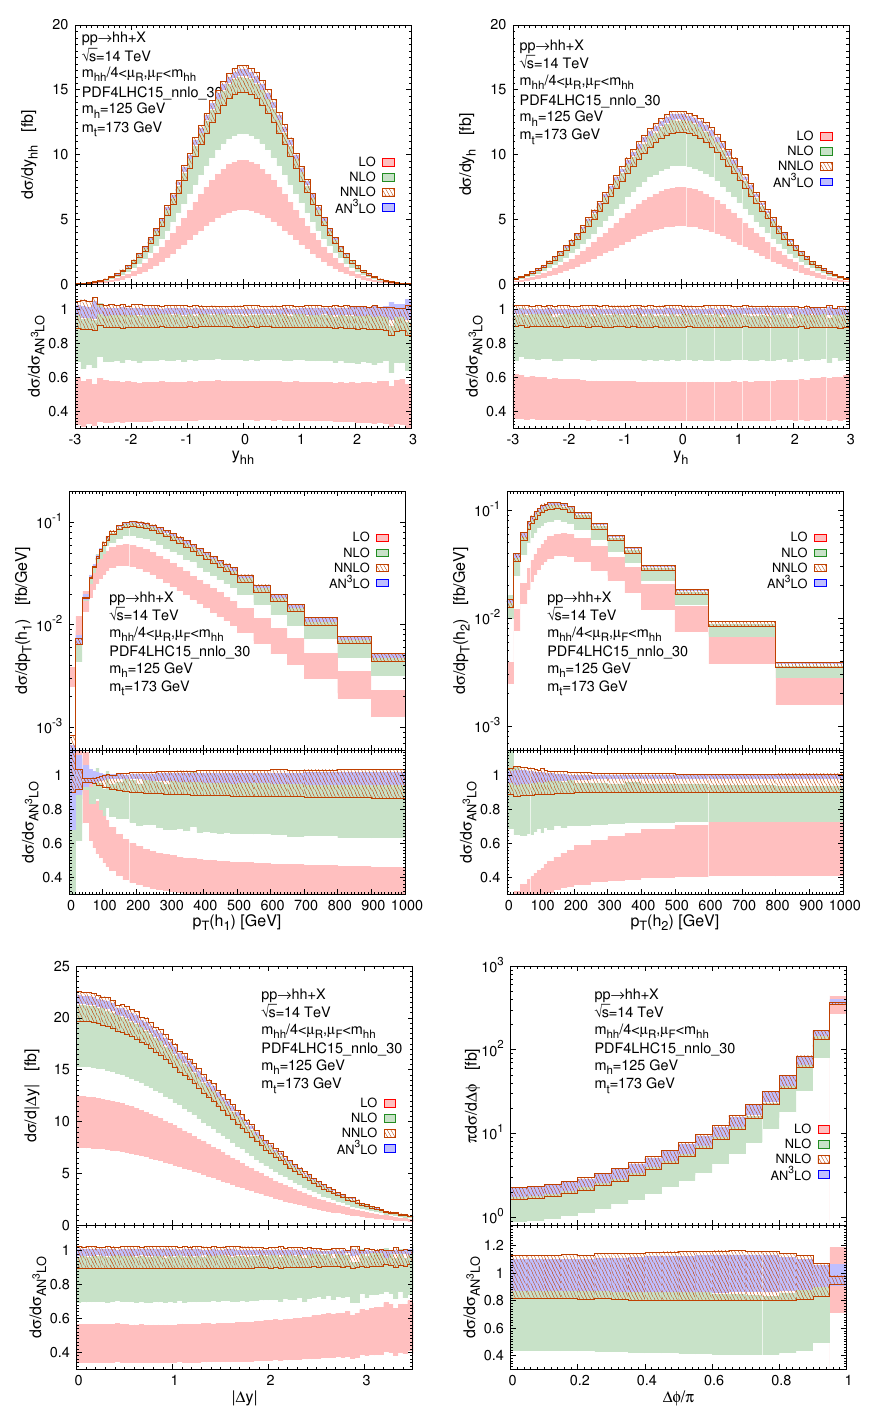
Figure 14 . Various distributions [ y hh (up left), y h (up right), p T ( h 1 ) (middle left), p T ( h 2 ) (middle right), (cid:1) y (low left), and (cid:1) (cid:30) (low right)] for the Higgs boson pair production in proton-proton p collisions at s = 14 TeV.